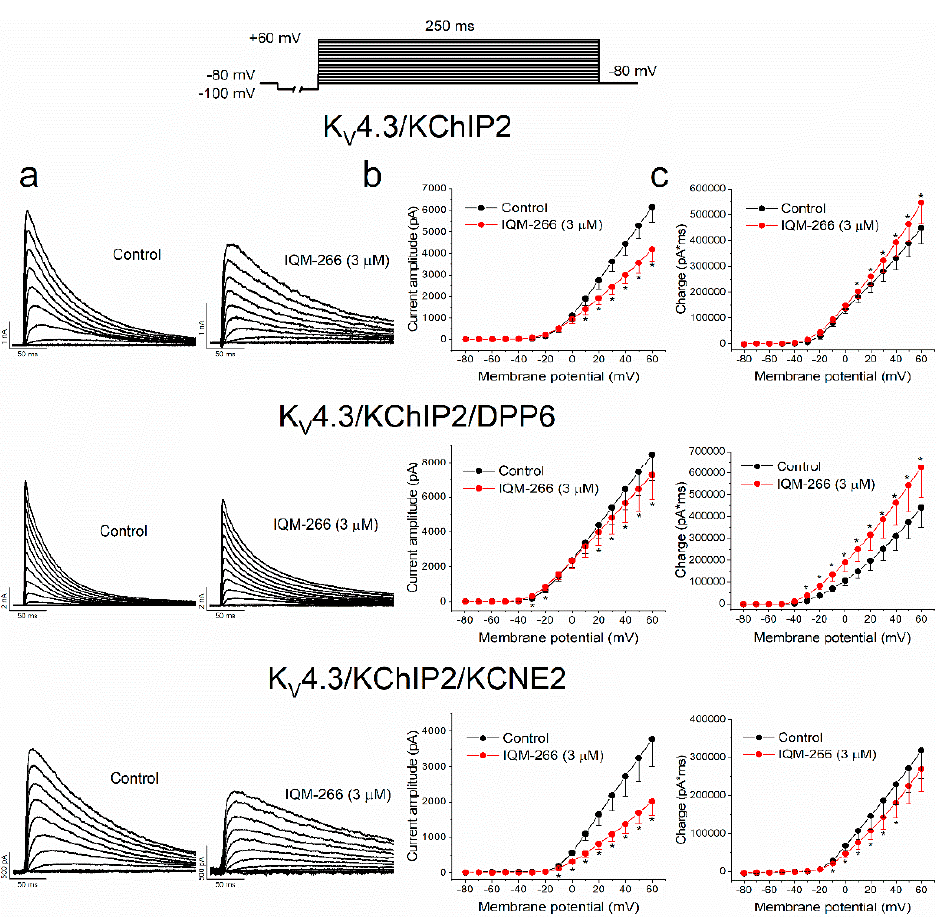
Figure 4. Voltage dependence interaction between IQM-266 and K V 4.3/KChIP2 K V 4.3/KChIP2/DPP6 and K V 4.3/KChIP2/KCNE2 channels. ( a ) Original recordings obtained elicited by the activation of K V 4.3/KChIP2, K V 4.3/KChIP2/DPP6 and K V 4.3/KChIP2/KCNE2 channels in the absence and in the presence of IQM-266 (3 µ M) after applying the pulse protocols shown in the upper part of the figure. ( b ) I-V relationship of the currents generated by K V 4.3/KChIP2 ( n = 7 cells from n = 7 transfections), K V 4.3/KChIP2/DPP6 ( n = 8 cells from n = 6 transfections) and K V 4.3/KChIP2/KCNE2 ( n = 10 cells from n = 8 transfections) channels in the absence and in the presence of IQM-266 at 3 µ M. ( c ) Q-V relationship of the charge through K V 4.3/KChIP2 ( n = 6 cells from n = 5 transfections), K V 4.3/KChIP2/DPP6 ( n = 8 cells from n = 6 transfections) and K V 4.3/KChIP2/KCNE2 ( n = 10 from n = 8 transfections) channels in the absence and in the presence of IQM-266 at 3 µ M, measured at the area under the current during the application of depolarizing pulse protocol shown in the upper part of the figure. Each point represents the mean ±